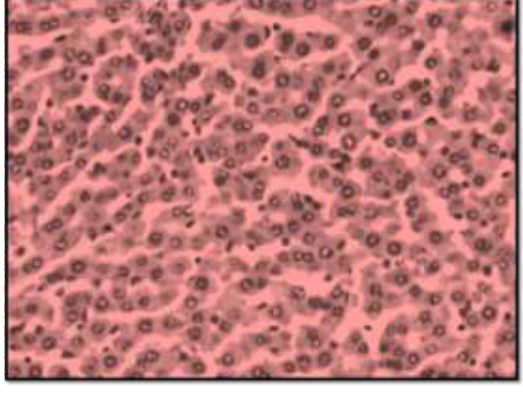
Figure 7b: Photomicrograph of Sudan black stained 5 µm thick frozen liver section showing congestion without Fat droplets (vacuoles) in rat hepatocytes on high-fat diet + Ginseng 400mg/kg (group 5) at